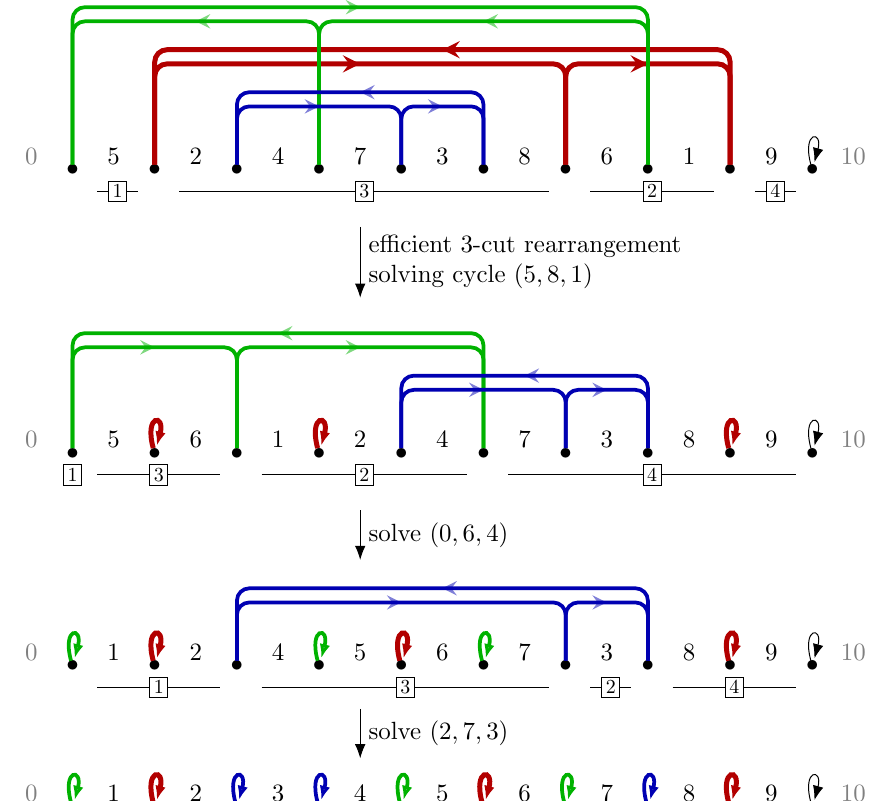
Figure 4. Example of a 3-cut rearrangement scenario from S = 524738619 to T = 123456789 using cycle graphs. From top to bottom: The cycle graph for ( S , T ) contains three non-trivial cycles and a trivial one (breakpoint u is depicted to the right of the label for u ). Blocks 1 to 4 of a 3-cut rearrangement (cutting after 5, 8, and 1) are given: it solves cycle 5 for short). Two other efficient rearrangements solve cycles ( 0,6,4 ) and ( 2,7,3 ) , thus reaching T in three steps. Note that some cycles do not admit efficient 3-cut rearrangement, e.g., ( 0,6,4 ) in the original permutation S